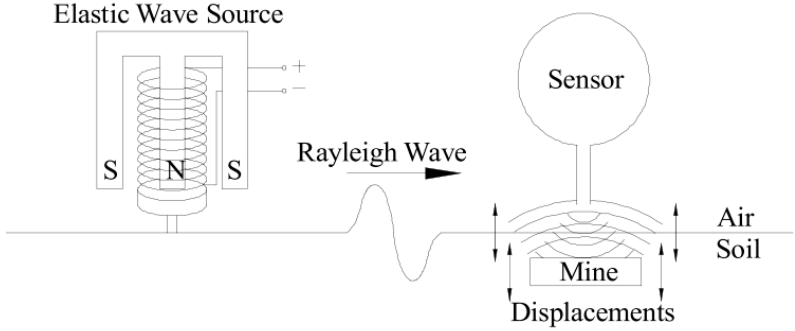
Figure 16. Mine detection system using surface wave method [107], Copyright IEEE, 2001.